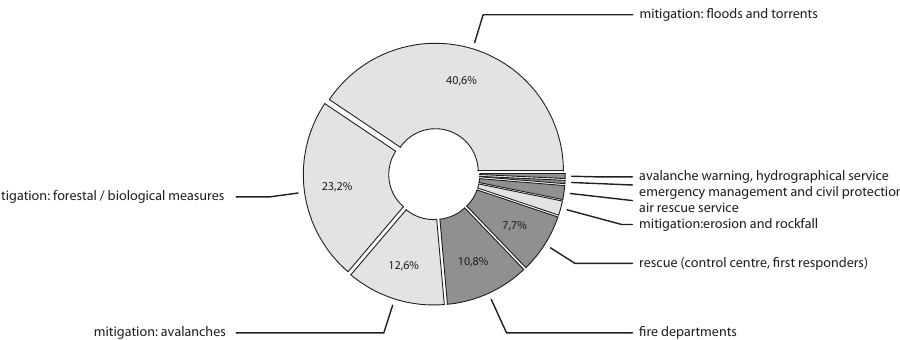
Fig. 2. Annual expenses in 2010 for public safety against natural hazards without wages and fixed assets in per cent for Tyrol, Austria (source: Federal State of Tyrol, 2010).